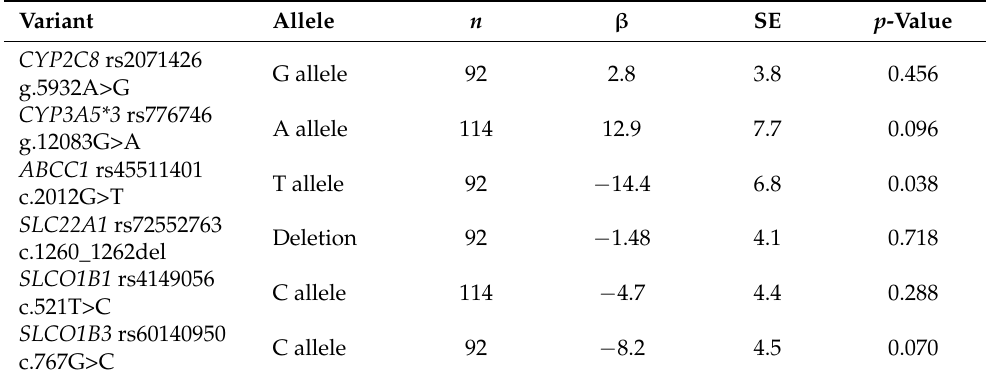
Table 5. Influence of deleterious variants (MAF > 10%) on LDL-c response to statins in FH patients: Multivariate linear regression